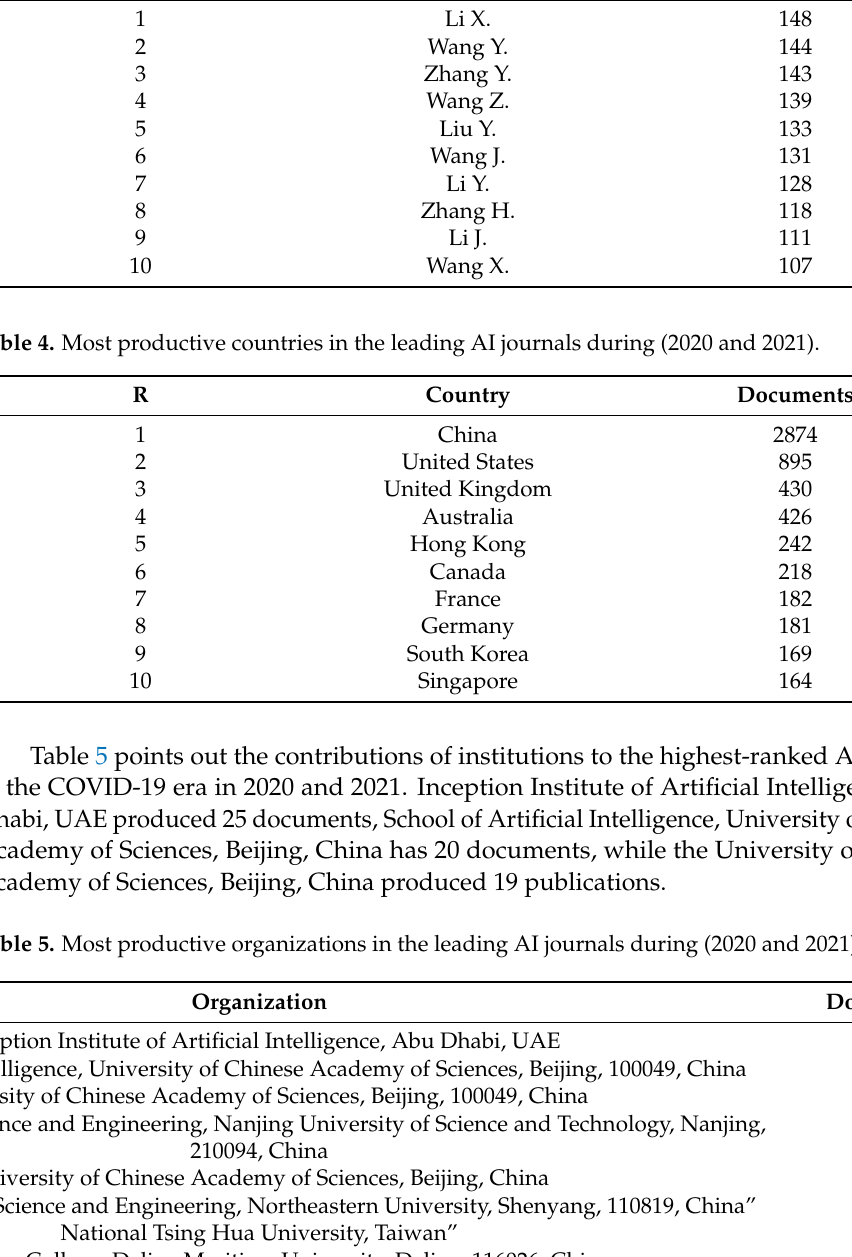
Table 3. Most productive authors in the leading AI journals during (2020 and 2021).